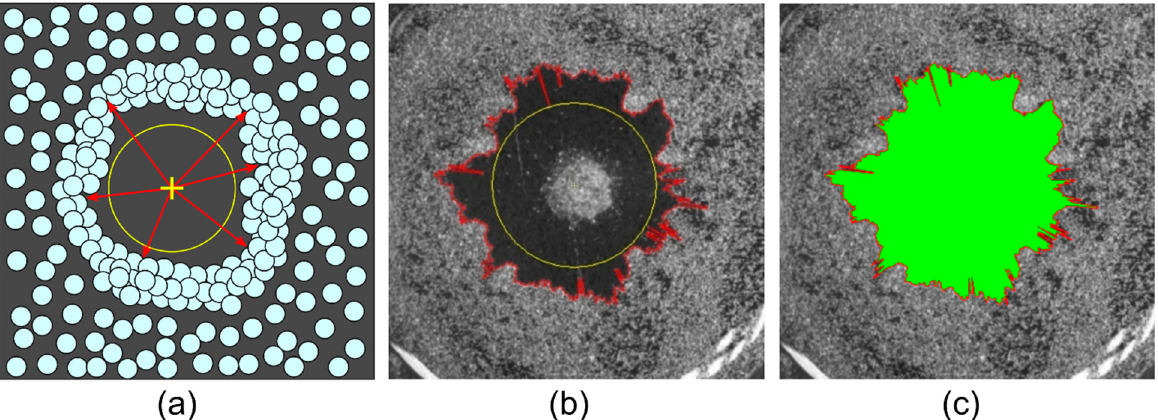
Figure 2. An illustration of the method for measuring the required area: ( a ) scheme of determining the boundary coordinates of the required area; ( b ) the drawing of a continuous line (a contour in red) enclosing the area; ( c ) the calculation of the desired area.